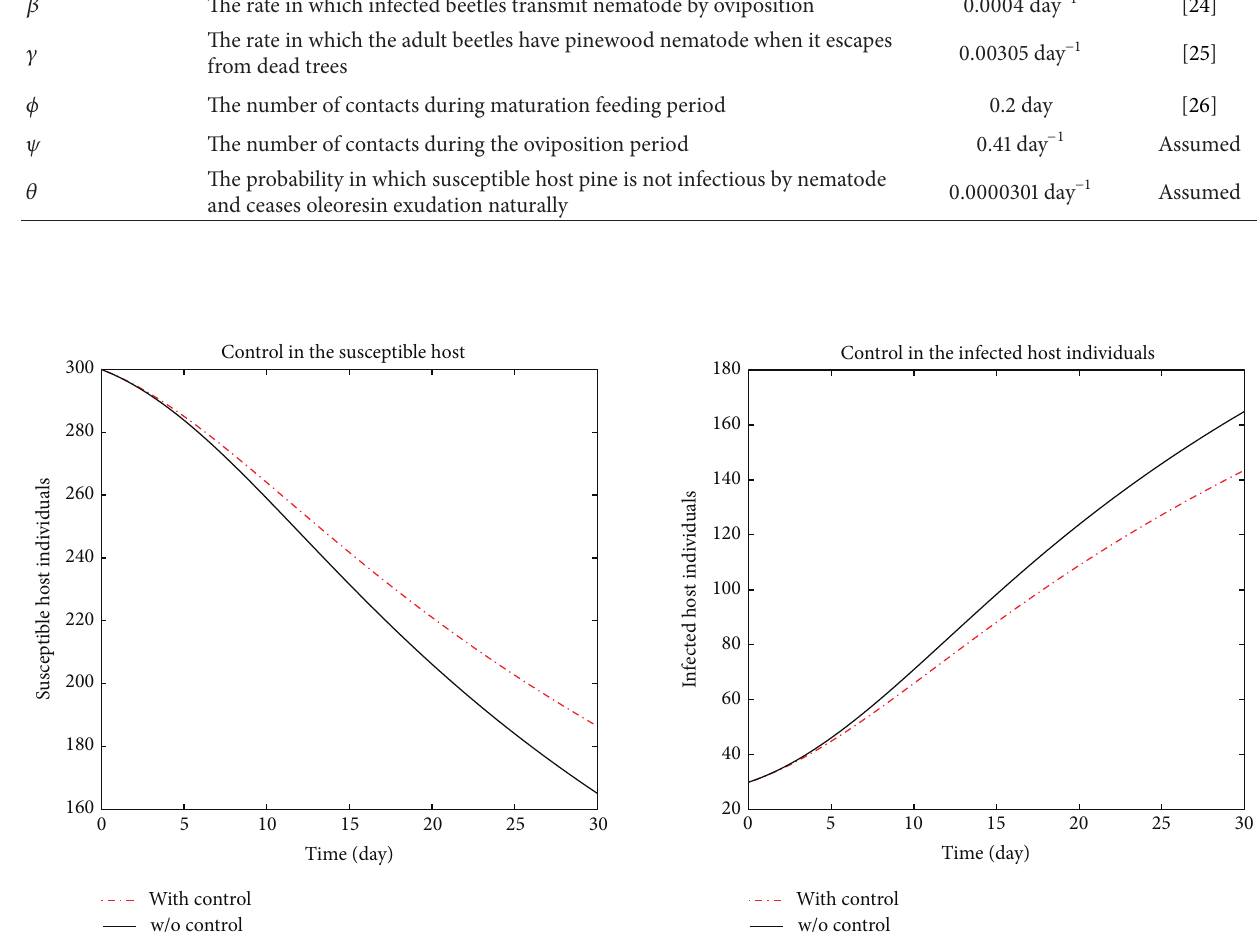
Figure 1: Plot of the number of susceptible hosts with and without control, 𝑢 1 ̸=0 , 𝑢 2 ̸= 0 .